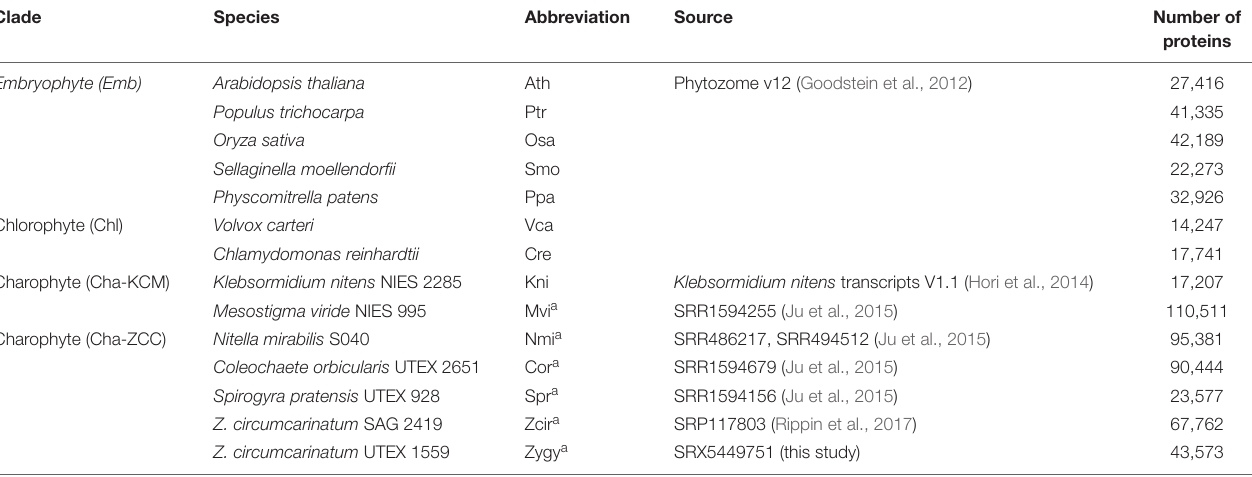
TABLE 2 | List of species and their protein